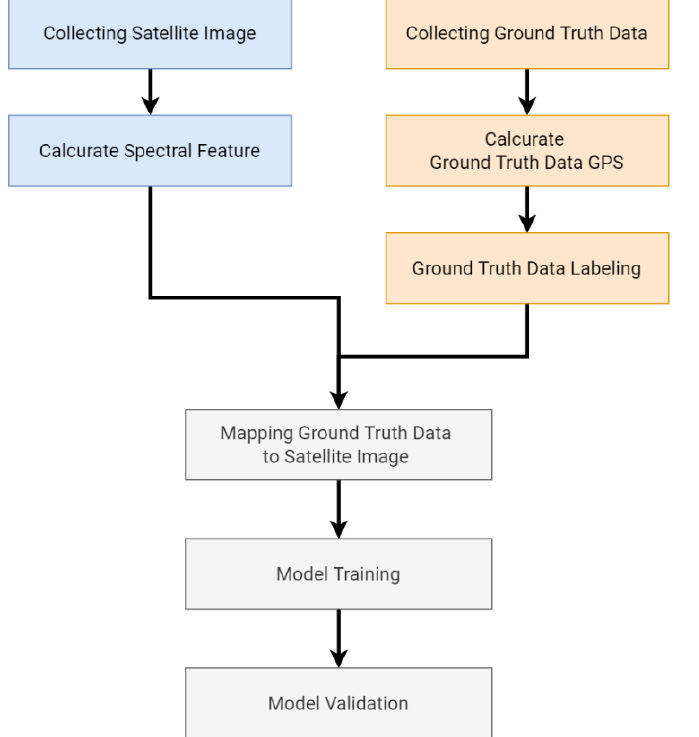
Figure 9. Flowchart of the methodology.